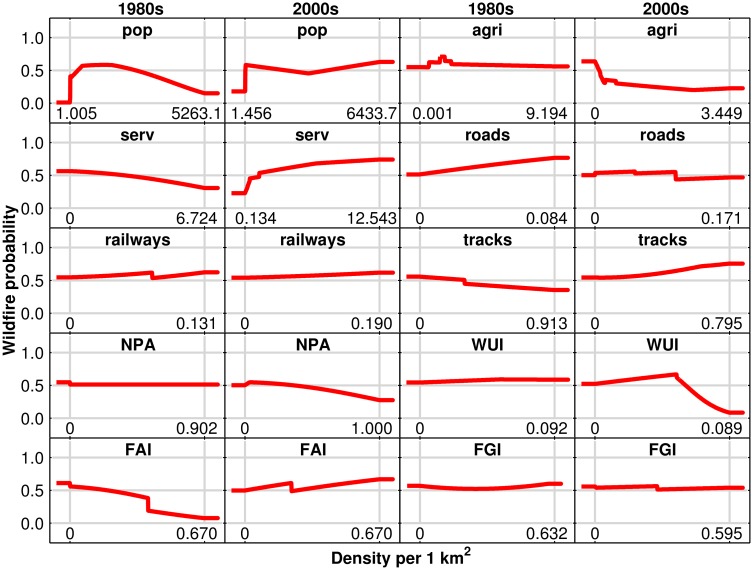
Curves indicate the mean wildfire predicted probability from Maxent in the 1980s and 2000s.